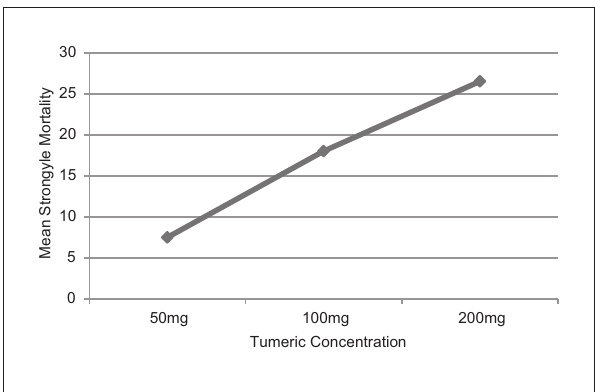
Figure-2: Mean non-motile strrongyle L3 following treatment with different concentrations of ethanolic extract of tumeric.